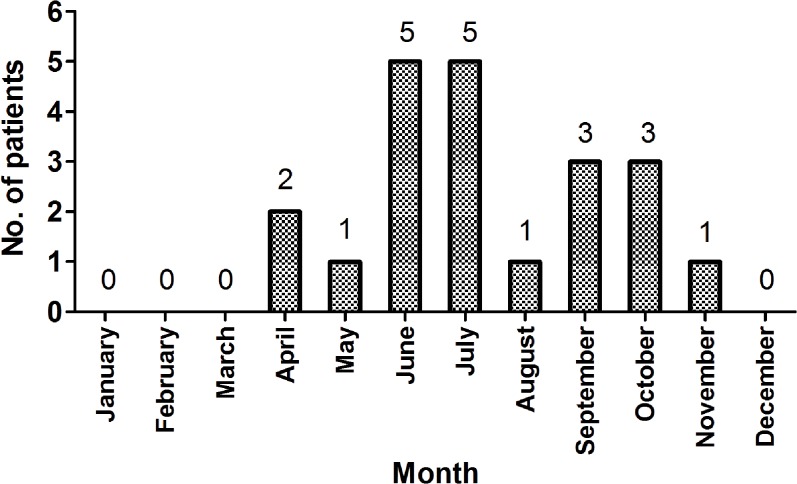
Seasonal distribution of V. vulnificus infections at the First Affiliated Hospital of Zhejiang University, School of Medicine, Hangzhou, China.